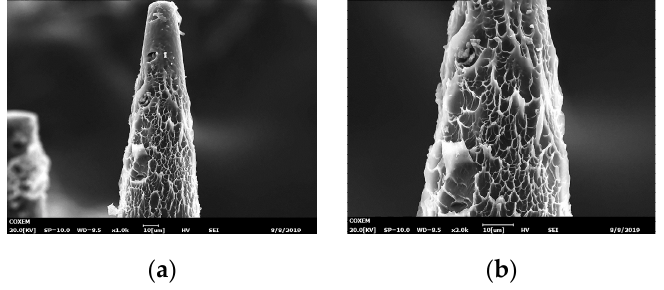
Figure 8. SEM of MNs with 300 ms exposure time: ( a ) tip of a needle; ( b ) surface of tip area. The scale bar is around 10 µm.